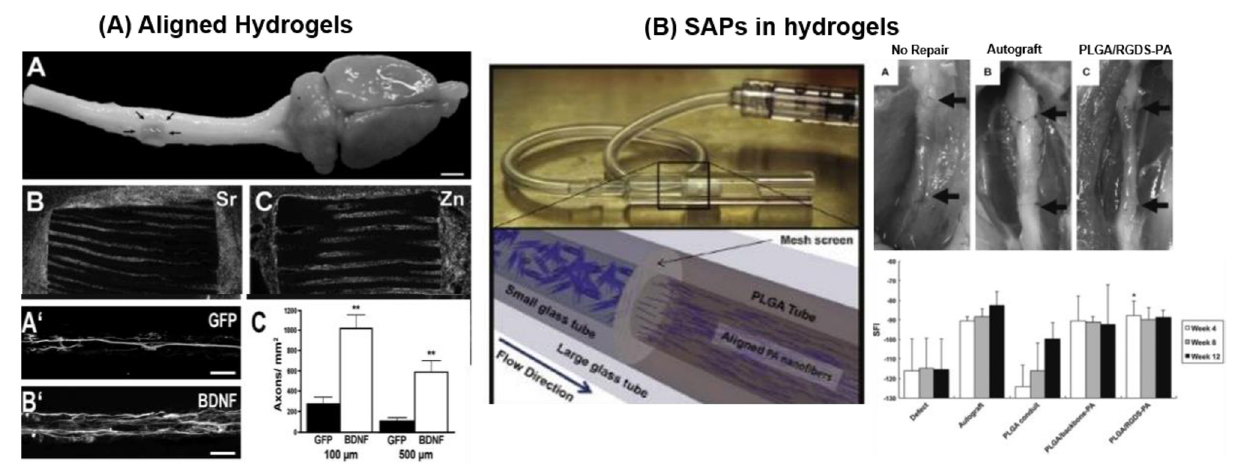
FIGURE 10 | Biomaterials applied for regeneration therapies (A) Alginate hydrogel scaffolds encapsulating BMSC (expressing GFP or BDNF) to promote directed linear axonal regeneration in the injured rat spinal cord model. Cell-filled alginate scaffold implanted at injured area with Sr 2 + and Zn 2 + ions staining demonstrates numerous cells within the channels. BMSC expressing BDNF cell preferentially promote axonal growth ( Günther et al., 2015) Copyright 2015, Elsevier; (B) PLGA based peripheral nerve construct filled with aligned PAs (PAs-RGD and PAs-IKVAV) for recovery of peripheral nerve injury. PAs solution, filled inside PLGA tubes was crosslinked by CaCl 2 . PAs-RGD filled PLGA construct provide faster recovery than bare PAs and comparable with autograft ( Li A. et al., 2014) Copyright 2014,